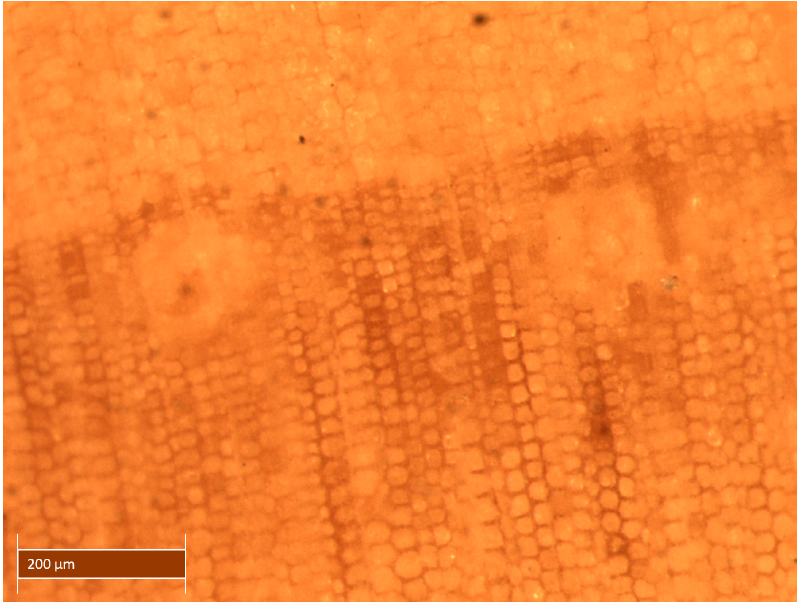
Figure 1. Image of two vertical resin ducts in the latewood of a limber pine growth ring.